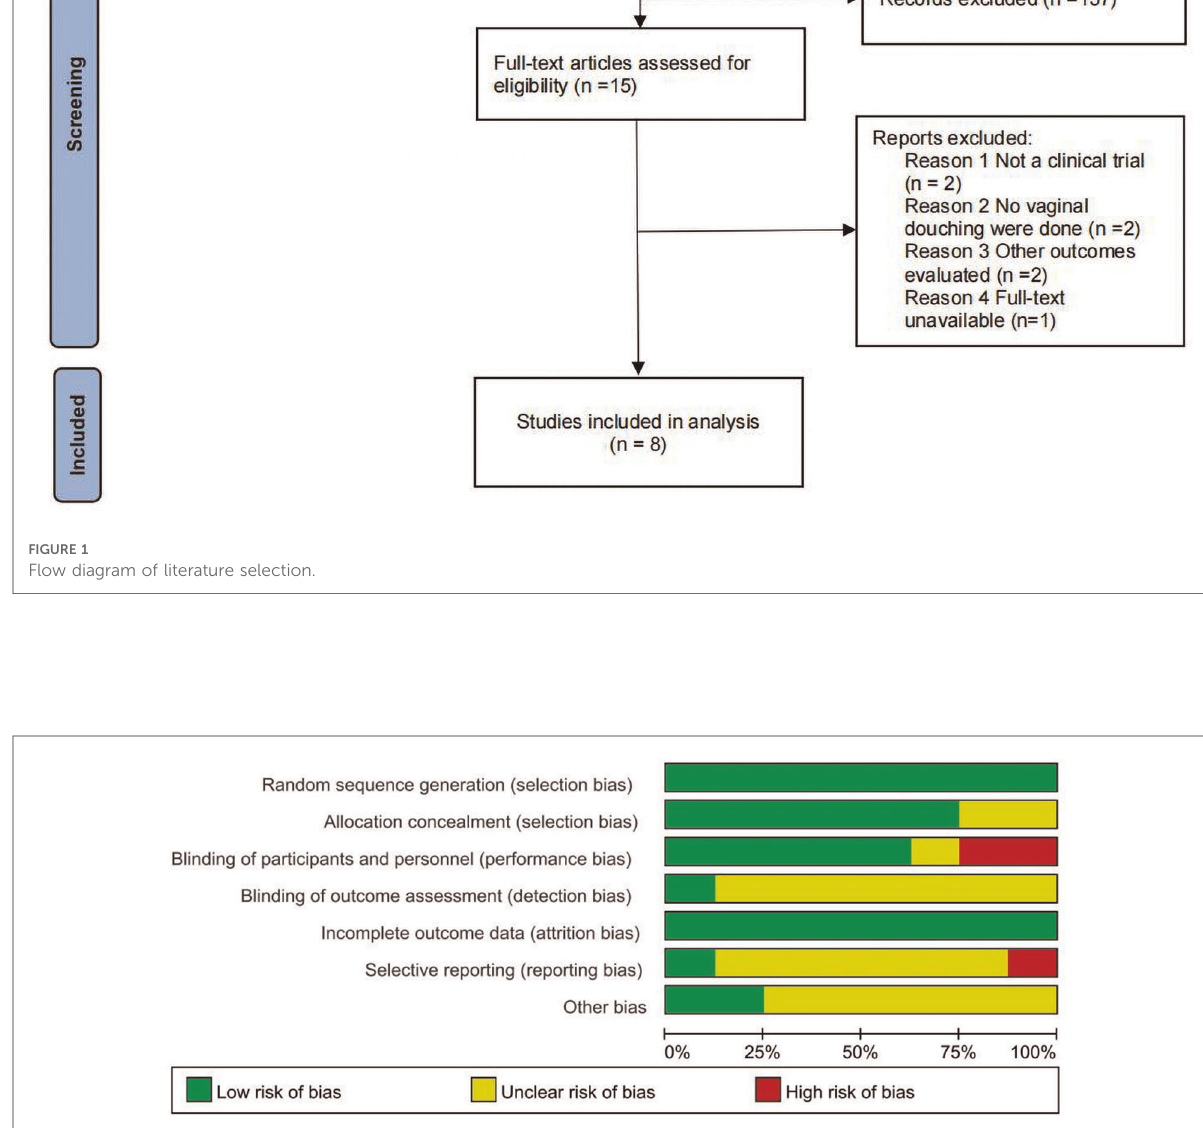
FIGURE 2 Risk of bias